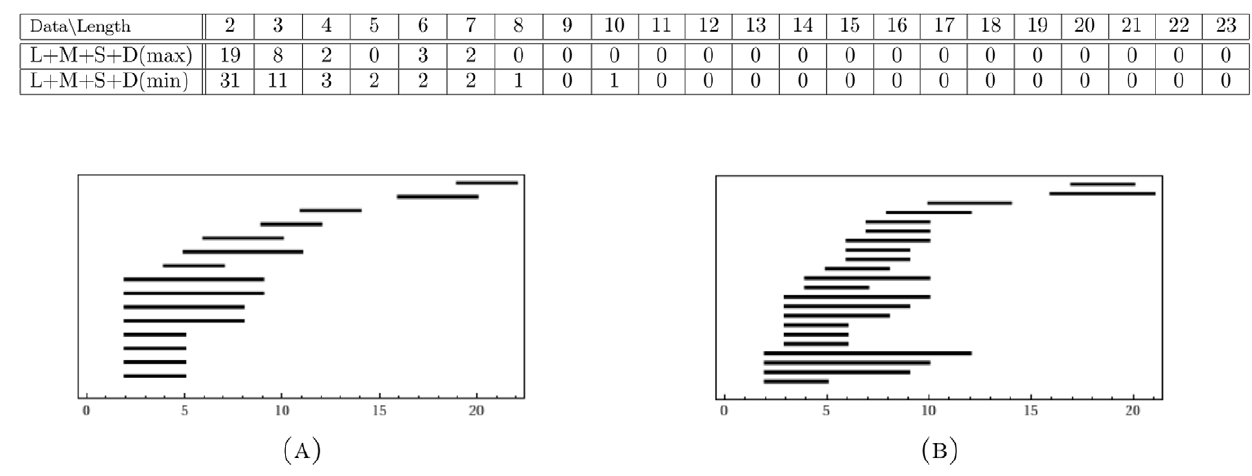
Figure 14. b 1 -persistence intervals (only lifespans w 2 are shown) for the combined data sets: (A) Combined(max) and (B) Combined(min).